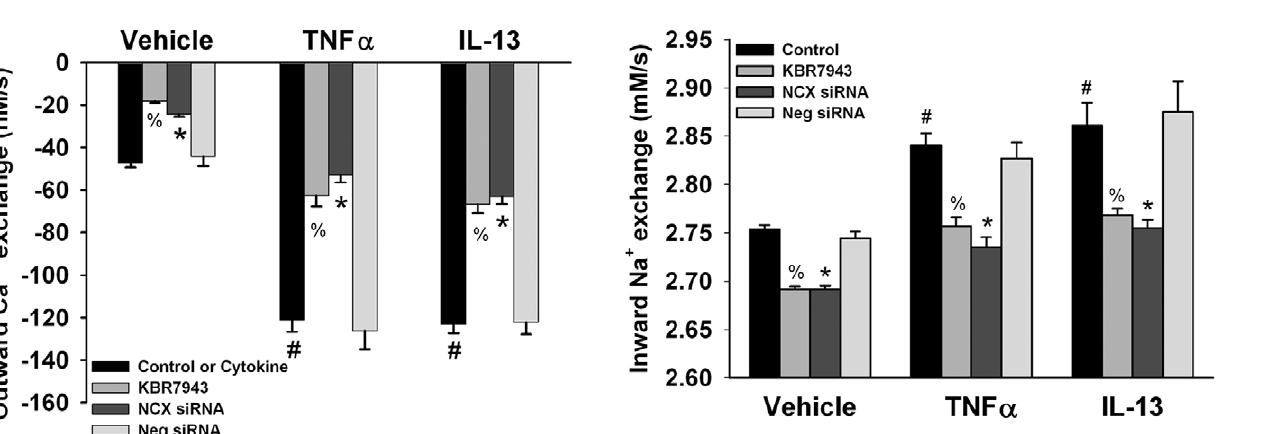
blunted cytokine effects on the observed Ca 2 + responses (p , 0.05; Figure 8). Negative siRNA did not affect cytokine-induced enhancement of outward mode NCX (Figure 8).